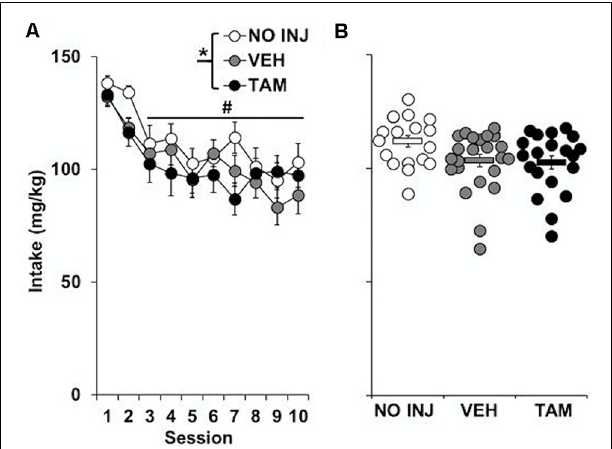
FIGURE 1 | Effect of tamoxifen on ExA cocaine self-administration. (A) Mean ( ± SEM) cocaine intake (mg/kg) for the no-injection (NO INJ; n = 18), vehicle (VEH; n = 24) and tamoxifen (TAM; n = 20) groups for each of the 10 ExA cocaine self-administration sessions. ∗ Significant group effect ( P = 0.048); # Significant effect of session (1–2 vs. 3–10, P < 0.0001) (B) Scatterplot of each individual rat’s mean cocaine intake across the 10 days of ExA cocaine self-administration. Solid bars represent the average values within each group ( ± SEM). SPSS (V26). Alpha was set at 0.05. Data are presented as the mean ±